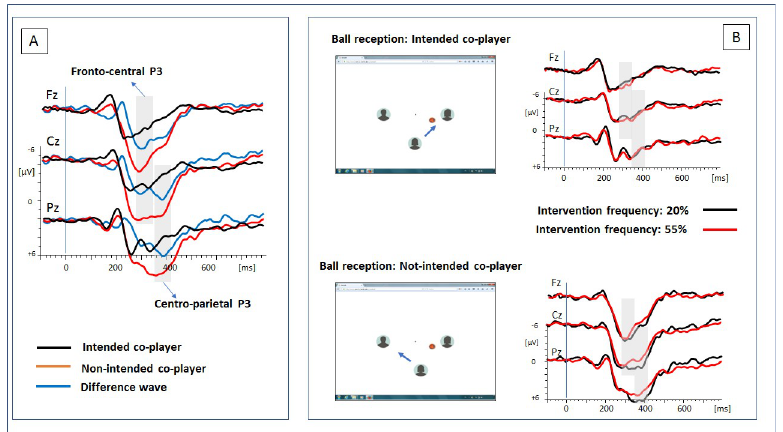
Fig 1. (A) Grand-averaged ERPs at midline electrodes Fz, Cz, and Pz separated for the experimental factor recipient (‘ball reception by intended co-player’ vs. ‘ball reception by non-intended co-player’). The difference waves illustrate two positive components: an early fronto-central P3a (290–350 ms) followed by a centro-parietal P3b (350–410 ms). (B) ERPs effects of the experimental factor intervention frequency (20% vs 55%) separated for the ball reception of the intended and non-intended co-player. Modulation of the P3 amplitudes—time ranges of the P3a and P3b are shaded— was restricted to the deviant event (non-intended co-player).